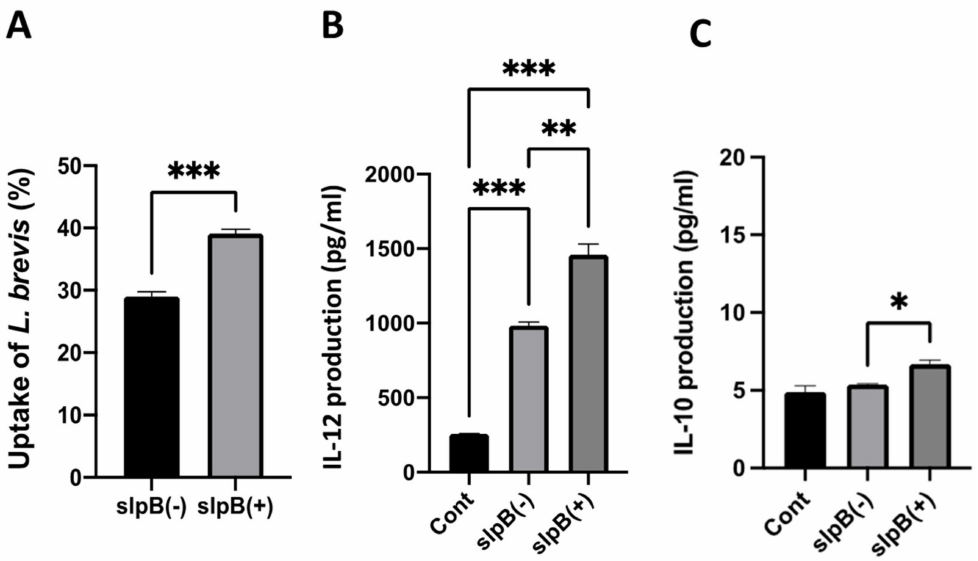
Figure 9. ( A ) Uptake of L. brevis JCM 1059 (slpB +) and LiCl treated JCM 1059 (slpB-) coating into THP-1 DC. ( B ) IL-12, and ( C ) IL-10 production by THP-1 DC after treatment with L. brevis with (+) or without (-) SlpB. (Means ± SD. * p < 0.05; ** p < 0.01, *** p <